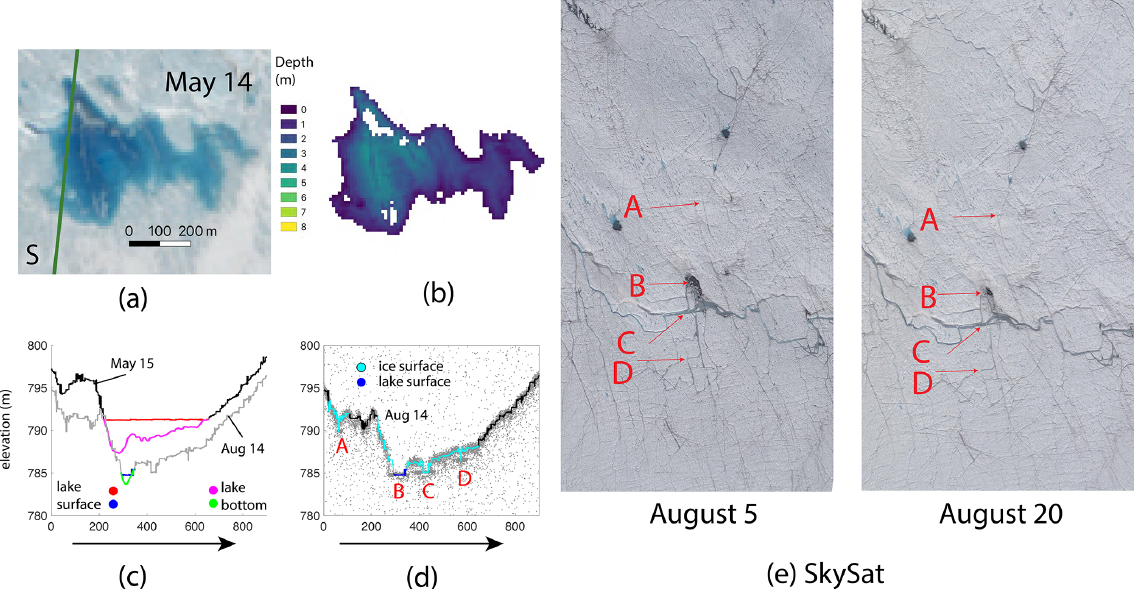
Figure 10. ICESat-2 RGT 727 over Lake Julian. (a) Sentinel-2-based imagery acquired on 14 May 2019 with ICESat-2 RGT 727 gt1l (occurring on 15 May and 14 August 2019) overlapping in green. Operation IceBridge overpass on 15 May 2019 is directly coincident with the ICESat-2 line. (b) Lake depth derived from Watta (c) and Sentinel-2 (a) imagery. (c) Watta calculated from ICESat-2 on 15 May and 14 August. (d) Watta-calculated surface features over photon cloud on 14 August. Points A–D discussed in text. (e) Points A–D shown over Planet SkySat imagery collected on 5 and 20